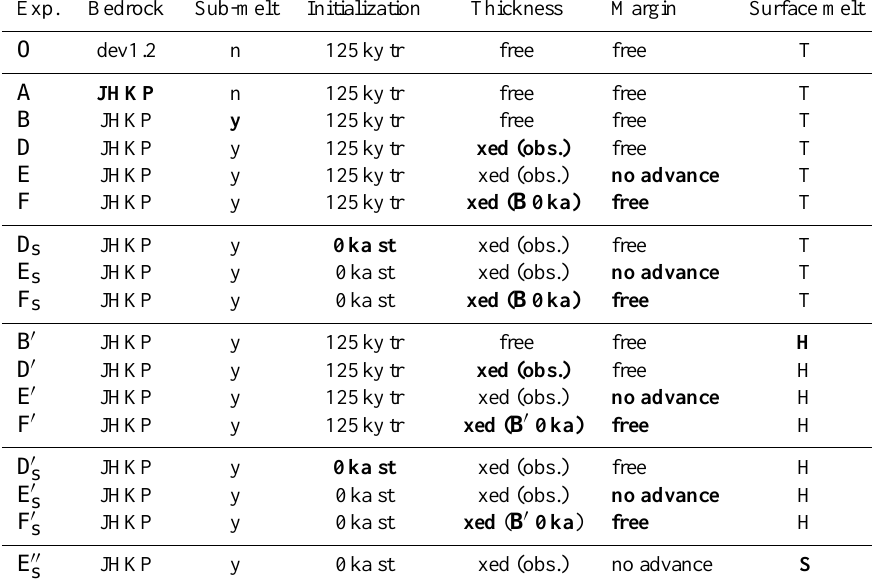
Table 1. Summary of numerical experiments in this paper. The bedrock column denotes the sources of bedrock topography as a boundary condition (see main text for interpretation of symbols). The column “sub-melt” denotes whether or not the sub-melt basal-sliding occurrence based on Eq. (3) is implemented. The initialization columns denote climate forcing used for initializing the ice-sheet topography, where “125kytr” stands for 125kyr transient forcing based on ice-core record. Thickness columns denote how the ice thickness is computed during initialization phase, where “free” means that ice thickness is allowed to evolve freely, “fixed (obs)” means that ice thickness is kept fixed as the present-day observation through the initialization phase artificially, and “fixed ( B 0ka)” means that ice thickness kept fixed as the simulated topography at 0ka obtained by experiments with configuration B . The margin column denotes whether the ice margin is allowed to advance freely (free) or limited to the initial condition (no advance) during future-climate experiments. The differences from the previous row are shown in bold. All the configurations are repeated with all the combinations of the basal-sliding coefficients (cases v1 , v2 , and v4 ) and the future-climate scenarios ( C0 , C1 , C2 , and C3 ). The experiment with suffix “s” (e.g., D s ) indicates steady-state initialization under the present-day conditions, which is denoted as “0ka st” in the initialization column. The experiments denoted with prime (like B (cid:48) ) means switching the method to compute surface melting from PDD following Tarasov and Peltier (2002) (denoted as “T” in the surface melt column) to PDD of Huybrechts and de Wolde (1999) (denoted as “H”). The table also includes an additional experiment E (cid:48)(cid:48) s shown in the Appendix, which uses another method of surface mass balance (indicated by symbol “S”). Details are described in the